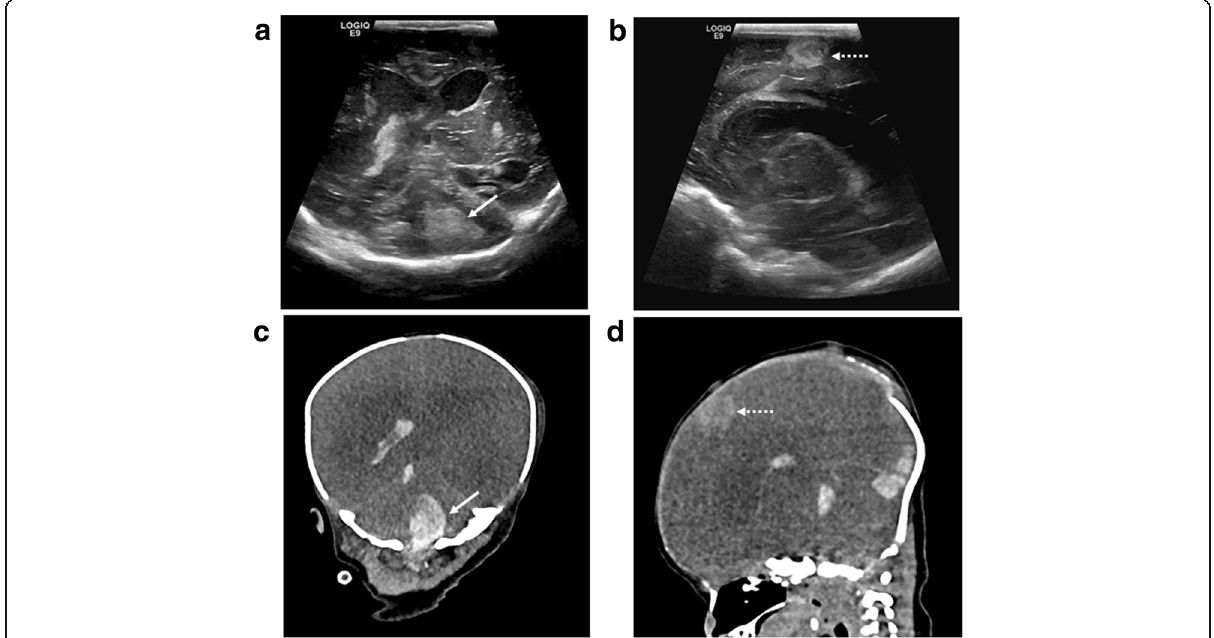
Fig. 9 Post-mortem cranial ultrasound images (top row), with matched unenhanced post-mortem CT images (bottom row) of a fourteen day old term neonate who died from a metastatic fibrosarcoma affecting the right thigh. Both imaging modalities were performed 3 days after death. The coronal ( a , c ) and sagittal ( b , d ) images demonstrate bilateral lateral ventricular dilatation with several hyperechoic and hyperdense metastatic deposits within the cerebellum (white arrows) and along the falx (dashed arrow). There is loss of grey white matter differentiation with poorly defined ventricles on the CT compared to ultrasound, given the significant underlying cerebral oedema